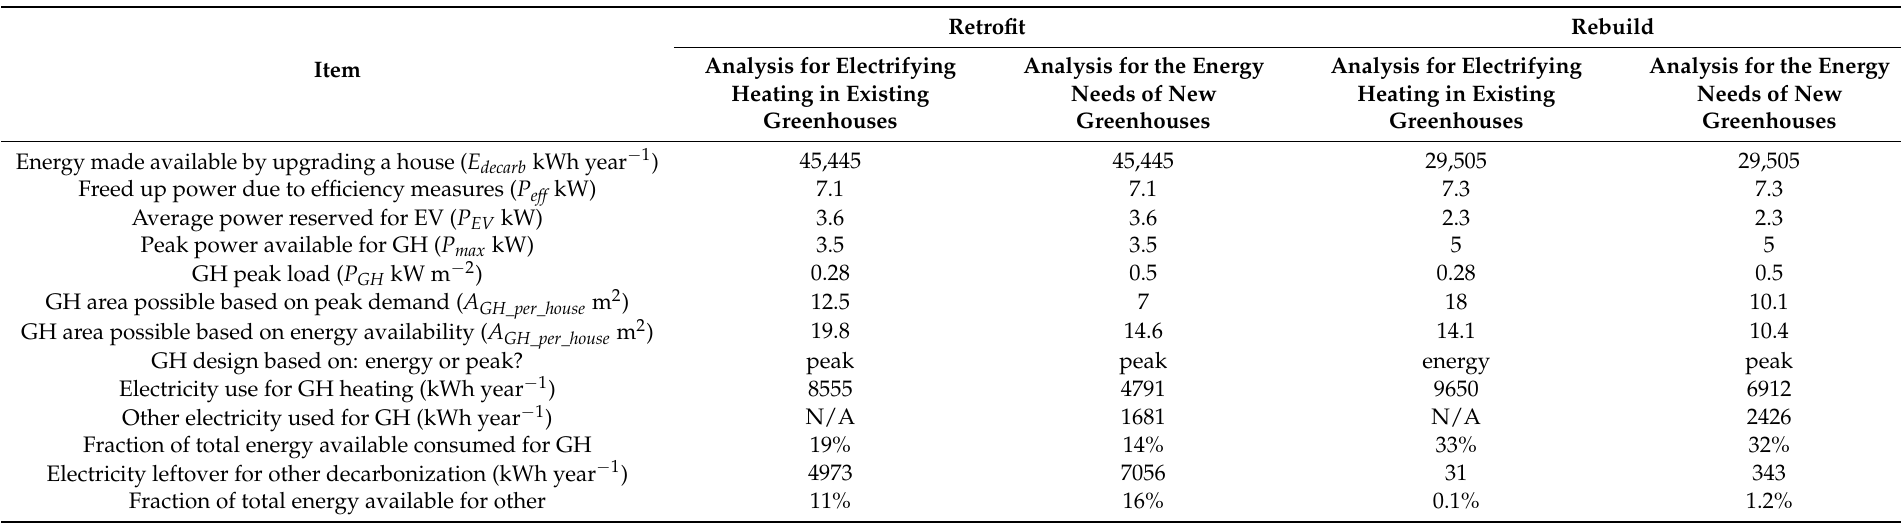
Table 5. Greenhouse (GH) area that can be decarbonized/operated using the energy that is made available from retrofitting/rebuilding a single-detached